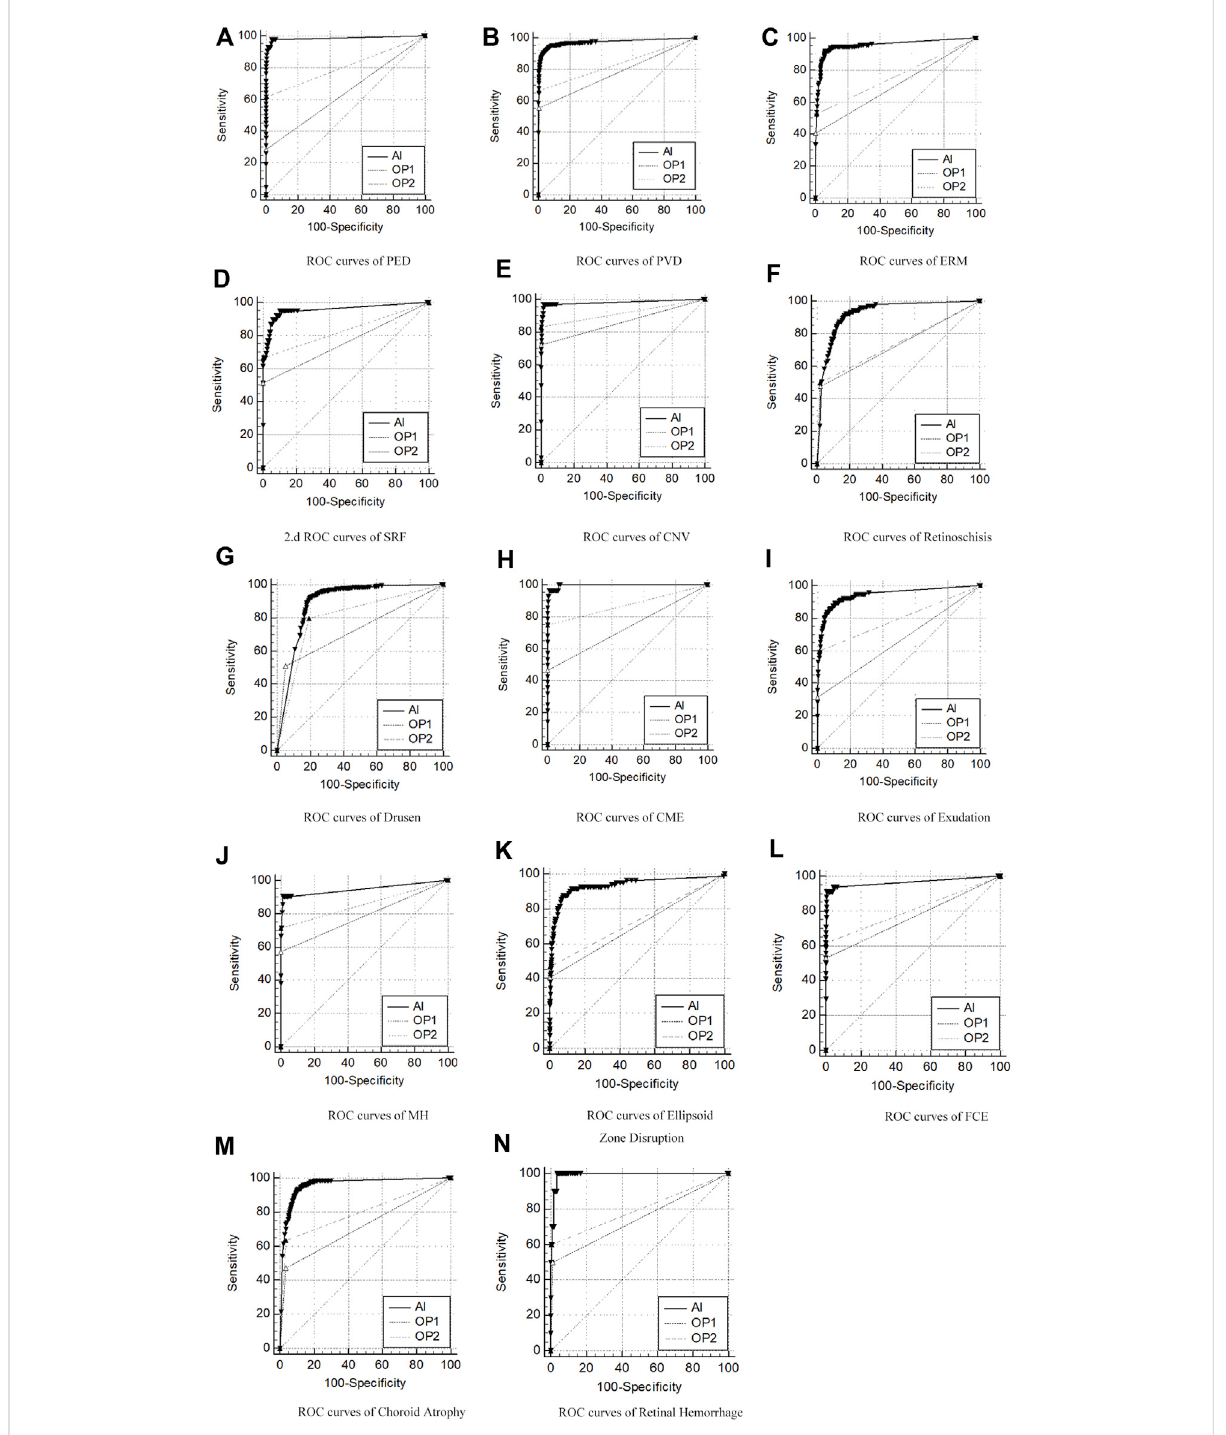
FIGURE 2 ROC curves of AI/group of junior ophthalmologists (OP1)/group of senior ophthalmologists (OP2) compared to the group of retinal specialists (OP3, as the golden standard) in diagnosis of 14 retinal disorders. (A – N) Pigment epithelial detachment (PED), posterior vitreous detachment (PVD), epiretinal membranes (ERMs), sub-retinal fl uid (SRF), choroidal neovascularization (CNV), drusen, retinoschisis, cystoid macular edema (CME), exudation, macular hole (MH), ellipsoid zone disruption, focal choroidal excavation (FCE), choroid atrophy, and retinal